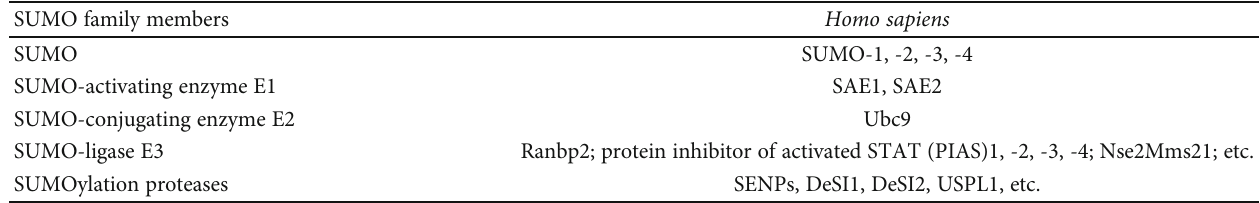
Figure 1: The SUMOylation pathway. All SUMO paralogues are synthesized as preproteins which are fi rst cleaved by sen trin-speci fi c proteases (SENPs) and then exposed to the carboxy-terminal diglycine (GG) motif. By consuming an ATP for activation by E1 (SAE1- SAE2), resulting in formation of a SUMO E1 thioester complex. The formation of a SUMO E1 thioester complex can be blocked by ginkgolic acid, anacardic acid, and kerriamycin B. SUMO is transferred to SUMO E2 and linked to a thioester, which can be inhibited by spectomycin B1. SUMO can be directly transferred to the target protein by Ubc9, or sometimes SUMO E3 ligases are also required to connect SUMO to the target proteins at their lysine residues, which can be inhibited by 2-D08 and reversed by SENPs. Table 1: Members of the SUMO